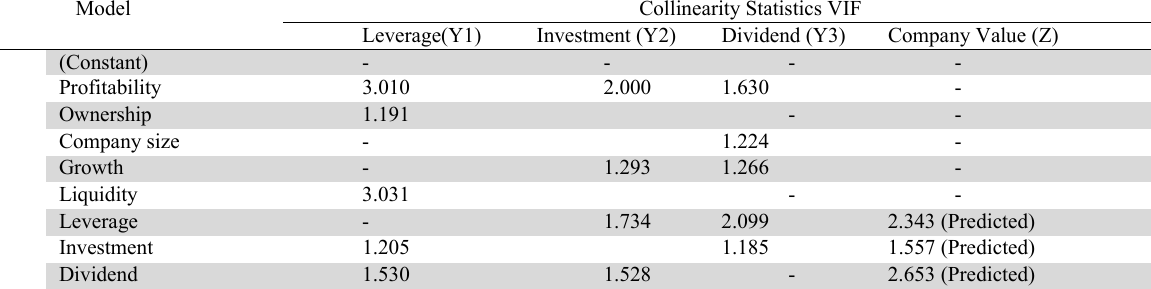
Multicollinearity test results for Leverage, Investment, Dividend, Company value Model